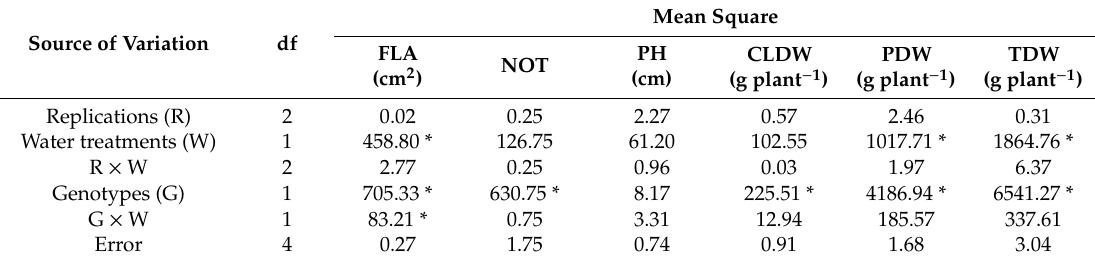
Table 2. Analysis of variance for morphological traits.